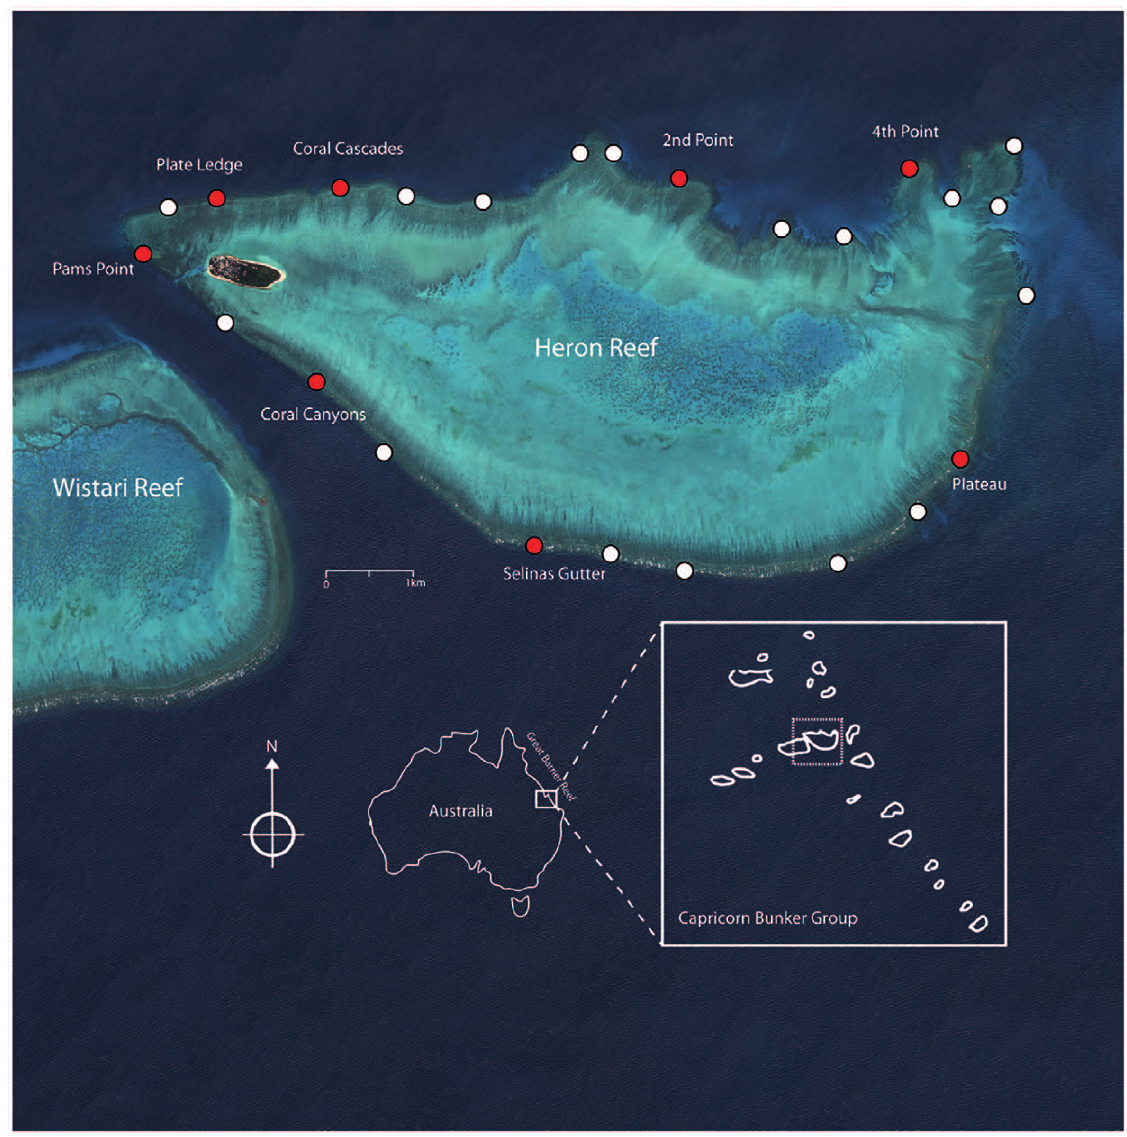
Figure 1. Location and regional setting of Heron and Wistari Reefs (Capricorn Bunker Group, Southern Great Barrier Reef). White circles indicate initial broad-scale sites surveyed for white syndrome presence ( n= 25), red circles indicate belt transect surveys for community structure and white syndrome prevalence ( n= 8).